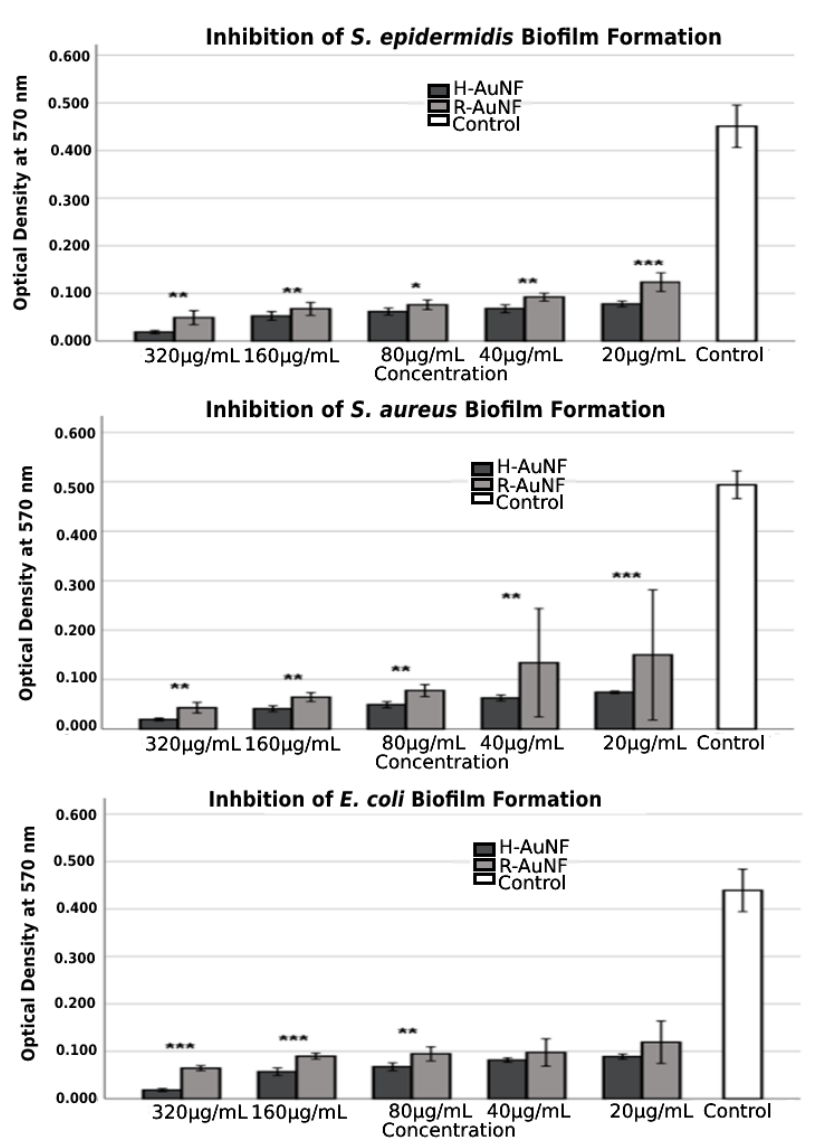
Figure 8. Biofilm inhibitory activity of AuNFs against selected bacteria strains at various concentrations. The error bars symbolized the SD of error mean (* p < 0.05; ** p < 0.01; *** p <0.001).